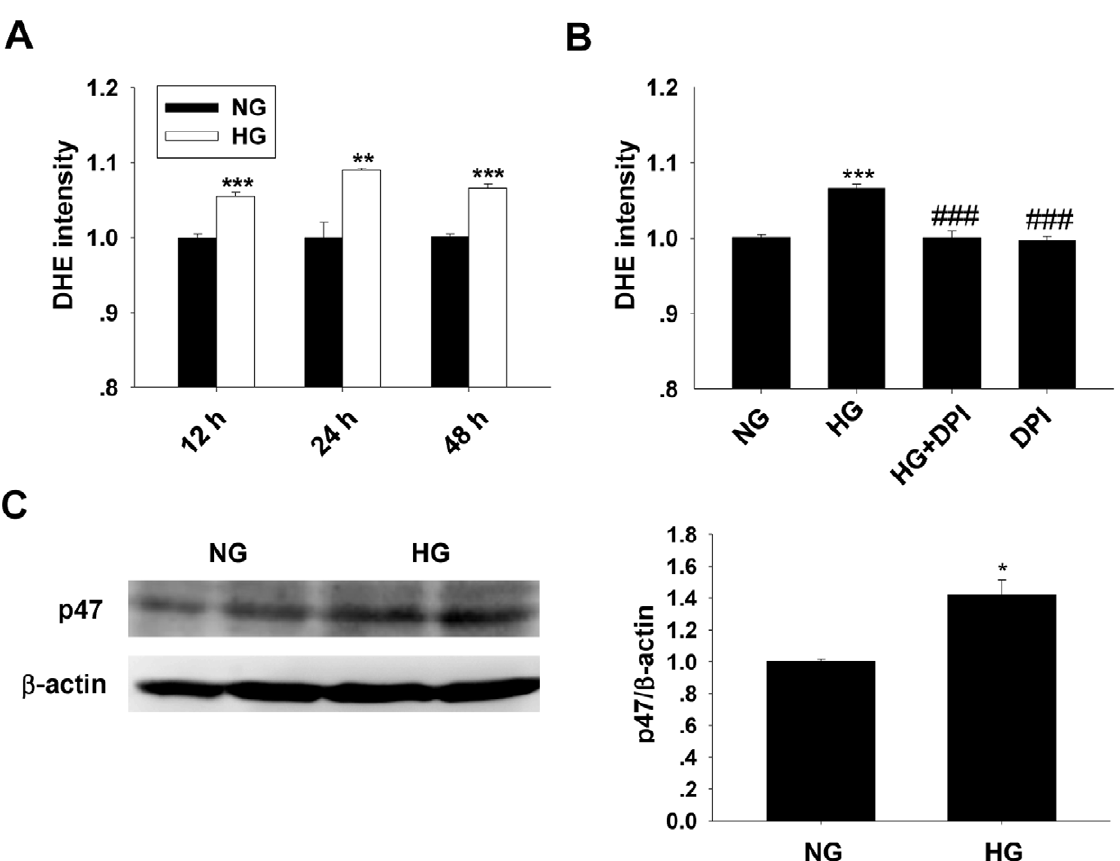
Figure 3. Effects of high glucose on ROS generation and p47phox expression. A and B: Observation of ROS generation by DHE fluorescent probe assay (mean 6 SEM, n=7). C: Western blot analysis on p47phox expression (mean 6 SEM, n=6). *** p , 0.001 compared to NG; ### p , 0.001 compared to HG.